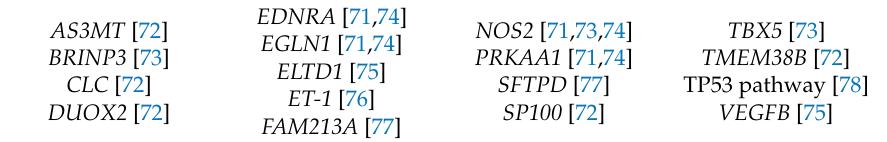
Table 2. Autosomal gene regions acted upon by natural selection in Andean